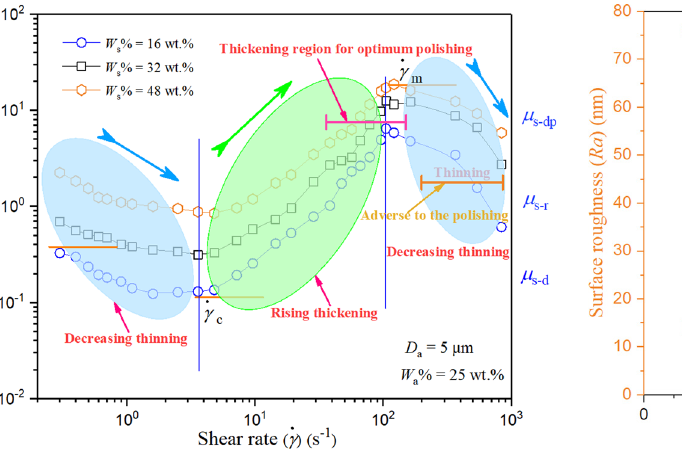
Figure 3: Three rheological curves of the experimental slurries ( fl ow viscosity vs shear rate ) .